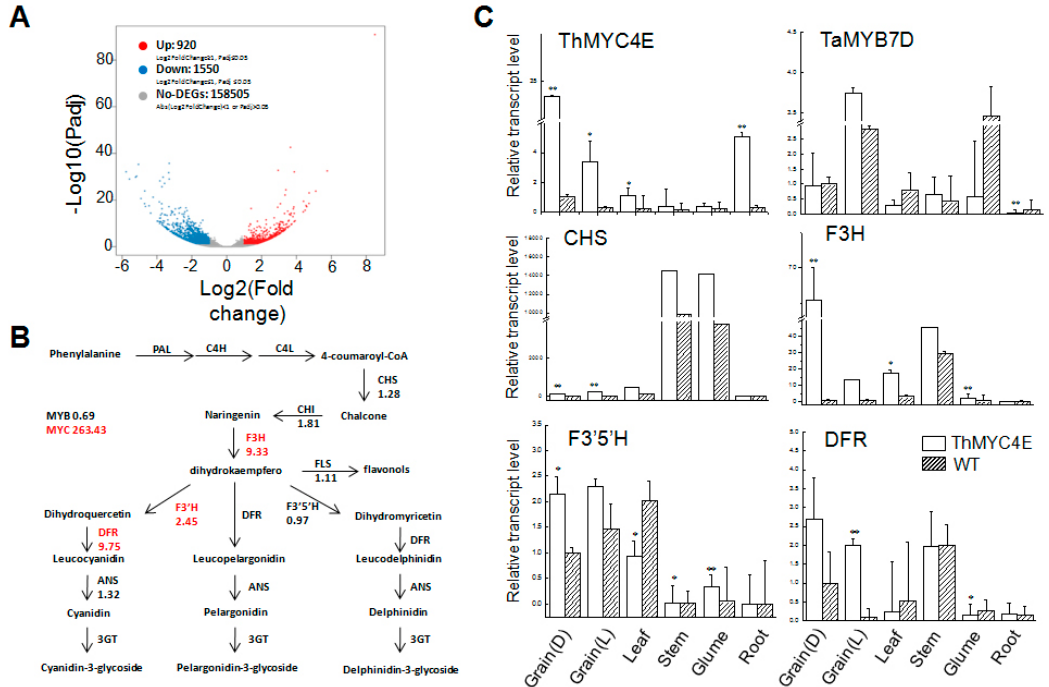
Figure 2. The transcript comparison of the grains in transgenic lines and WT. ( A ) Differentially expressed genes in the grains of transgenic lines and WT as seen following the RNA-seq experiment. The genes were categorized into three classes. Red genes were up-regulated if the gene expression of right-hand sample was larger than the left-hand sample. Blue genes were down-regulated if the gene expression of left-hand sample was larger than the right-hand sample. Grey genes were not di ff erentially expressed. The horizontal coordinate is Log 2 (fold change) and the vertical coordinate is -Log 10 (Padj). ( B ) The di ff erences in expression of structural genes in the anthocyanin biosynthesis pathway based on RNA-seq experiment. Arrows show the metabolic stream, the left or upward arrows represent the genes catalyzing the progression of synthesis, the number represents the increased time of expression in the grain of transgenic lines compared with the WT. ( C ) The relative transcript level of the transcription factors and the selected structural genes relative to anthocyanin biosynthesis in di ff erent tissues 28 days after flowering. D = dark treatment (control), while L = light treatment. Vertical bars are error bars. All data were compared with the wild type and transgenic lines (* p < 0.05 and ** p < 0.01)